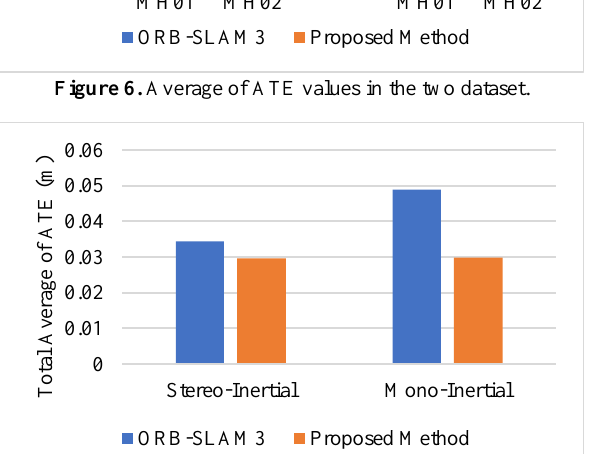
Figure 7. Total average of ATE values in stereo-inertial and mono-inertial modes.